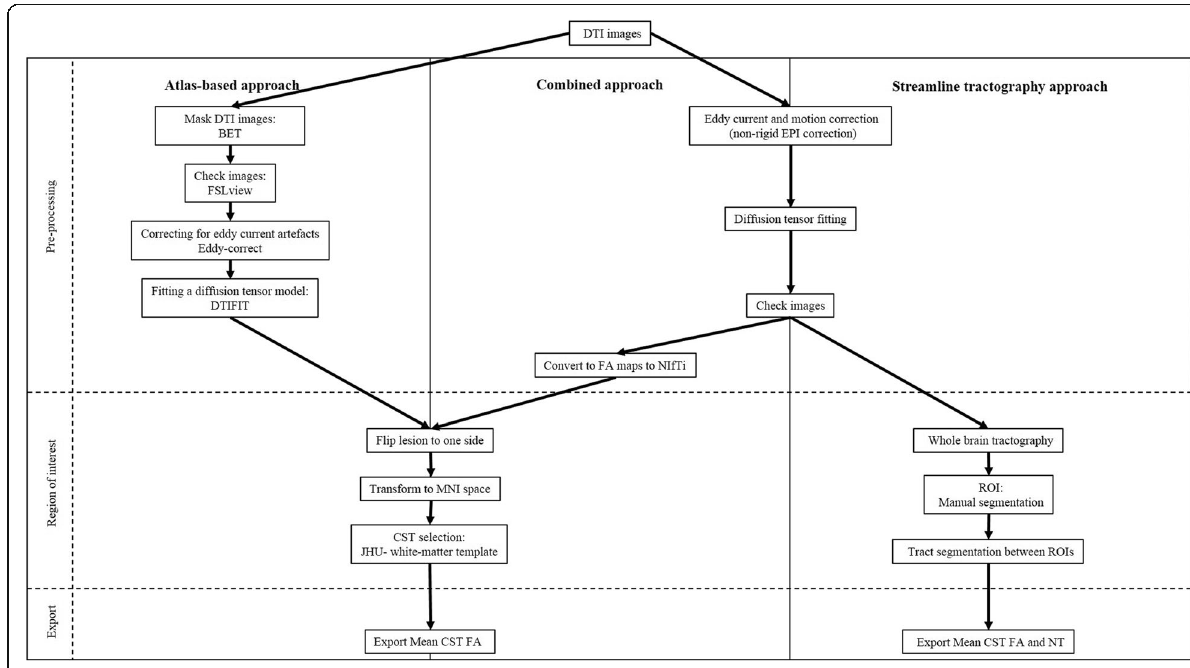
Fig. 1 Workflow for the data processing in the different approaches. BET , brain extraction tool; CST , corticospinal-tract; DTI , diffusion tensor imaging; EPI , echo planar imaging; FA , fractional anisotropy; FSL , FMRIB software library; JHU , Johns Hopkins University; MNI , Montreal Neurological Institute; NIfTi , Neuroimaging Informatics Technology Initiative; NT , number of tracts; ROI , region of